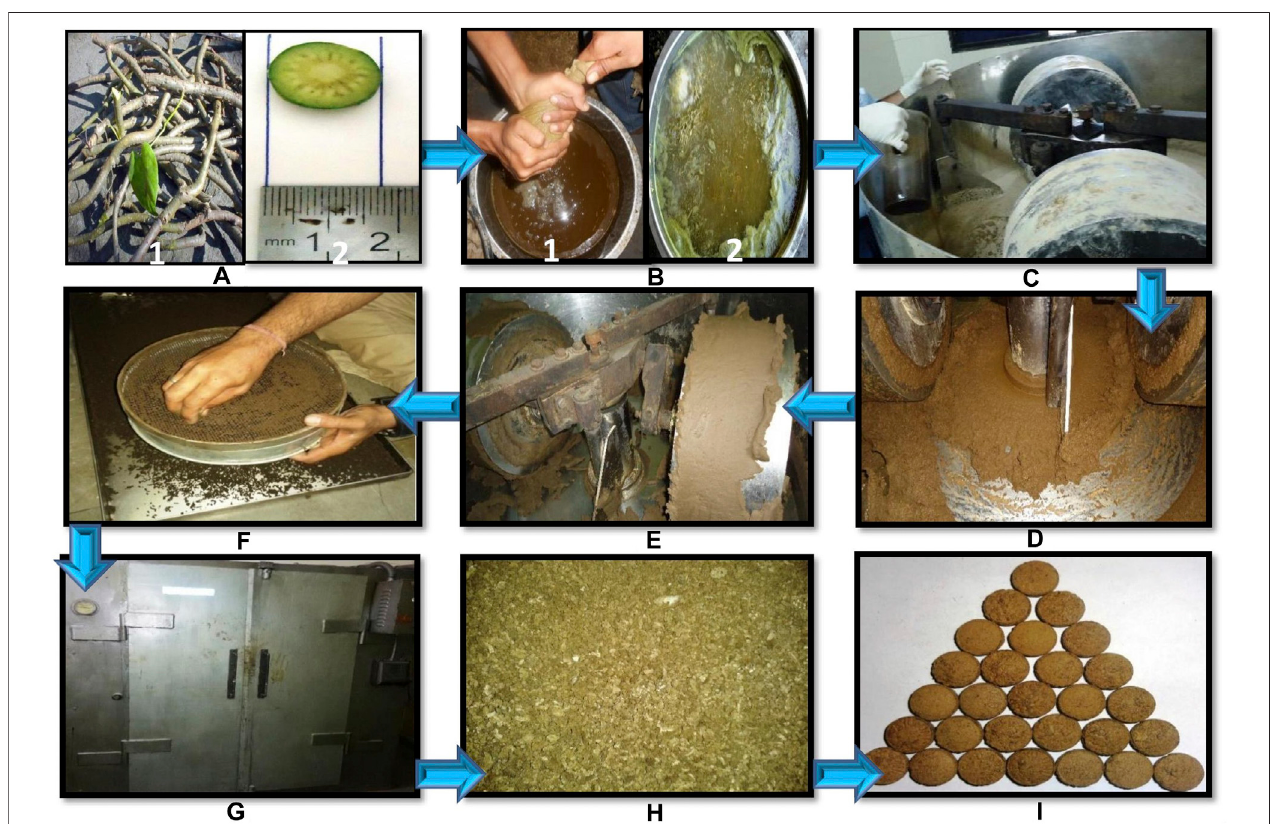
FIGURE 1 | Unit operating process of Svarasa Bhavita Guduchi Churna (SBGC), Kwatha Bhavita Guduchi Churna (KBGC), and Jala Bhavita Guduchi Churna (JBGC) samples preparation by traditional Bhavana method. (A) - (1) fresh Guduchi stems (2) chopped/crushed, (B) - (1) expressed juice (for SBGC batch) (2) decoction wasprepared(forKBGCbatch), (C) -wetgrindingofGuduchiChurmawithliquidmedia(GuduchijuiceforSBGCbatch,GuduchidecoctionforKBGCbatch,andpotable waterforJBGCbatch)inedge-runner, (D) -softand fi nemassformedduringgrinding, (E) -observationofSubhavitaLakshana(Con fi rmatorytestsforcompletionof levigation), (F) - wet granulation, (G) - hot air over drying, (H) - dry granules, (I) - preparation of